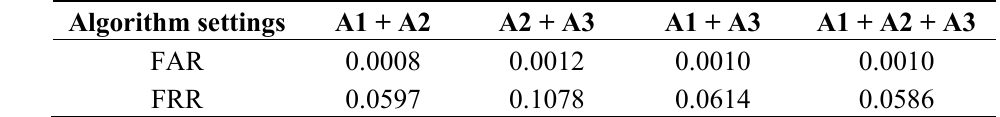
Table 4. Best performance (operation points closest to the performance target FRR ≤ 0.01 @ FAR = 0.001)—multi-algorithm fusion.